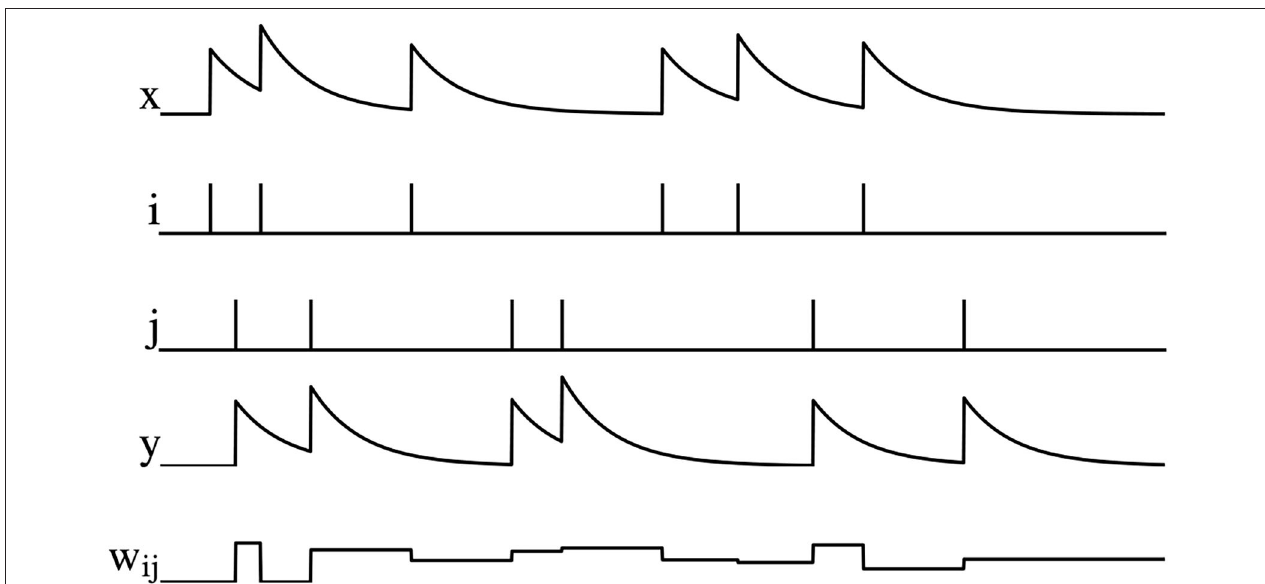
FIGURE 2 | Illustration of PSTDP, where x is the pre-synaptic spike trace, i is the spikes of pre-synaptic neuron, j is the spikes of post-synaptic neuron, y is the post-synaptic pike trace, and w ij is the synaptic